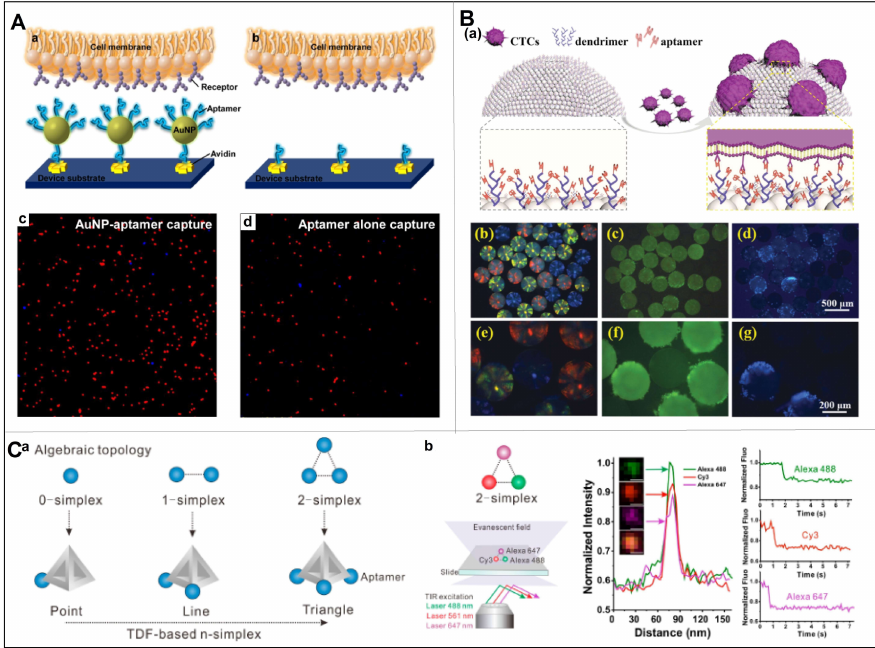
Figure 3. ( A ) Platform of multivalent aptamer nanospheres in microfluidic devices for separating tumor cells from blood, as well as the cells capture results of AuNP-aptamer and aptamer alone. ( a , b ) Enhanced CTCs capture with AuNP-aptamer that could bind toward multiple receptors on the cell membrane. ( c , d ) Monovalent interaction with aptamer alone to bind receptors on the cell membrane. Reproduced with permission from [27]. ( B ) Barcode particles capable of capturing and releasing various types of CTC. ( a ) Enhanced CTC capture with barcode particles that were decorated with dendrimer and DNA aptamers. ( b ) Optical microscopy image, ( c ) green fluorescent image, and ( d ) blue fluorescent image of the barcode particles with captured CTCs. ( e – g ) Enlarged images of ( b – d ), respectively. Reproduced with permission from [28]. ( C ) TDF programming method for the efficient capture of CTCs by receptor-ligand interactions on topologically engineered cell membranes. ( a ) Representations of algebraic topology (0-simplex indicates one point, 1-simplex indicates a line, and 2-simplex indicates a triangle). ( b ) Single channel and merged total internal reflection fluorescence microscopy images of the 2-simplex, as well as the corresponding colocalization curves and stepwise photobleaching curves. Reproduced with permission from